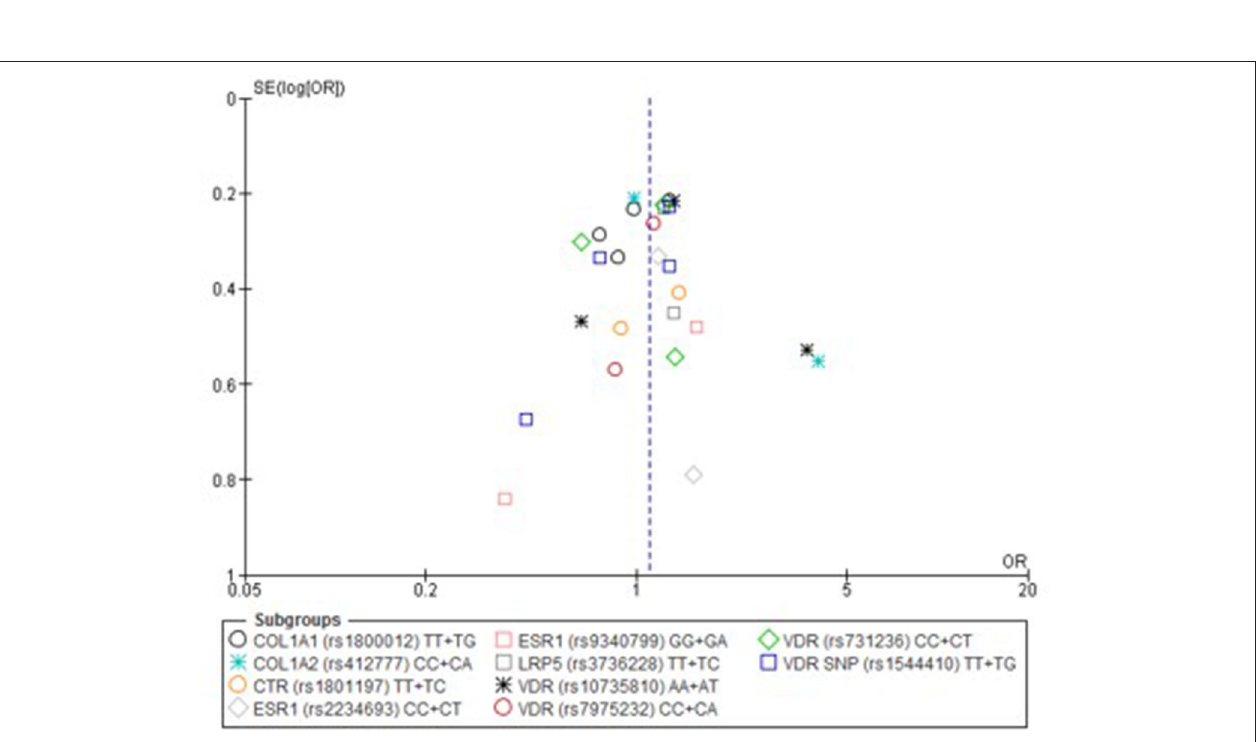
Frontiers in Genetics |